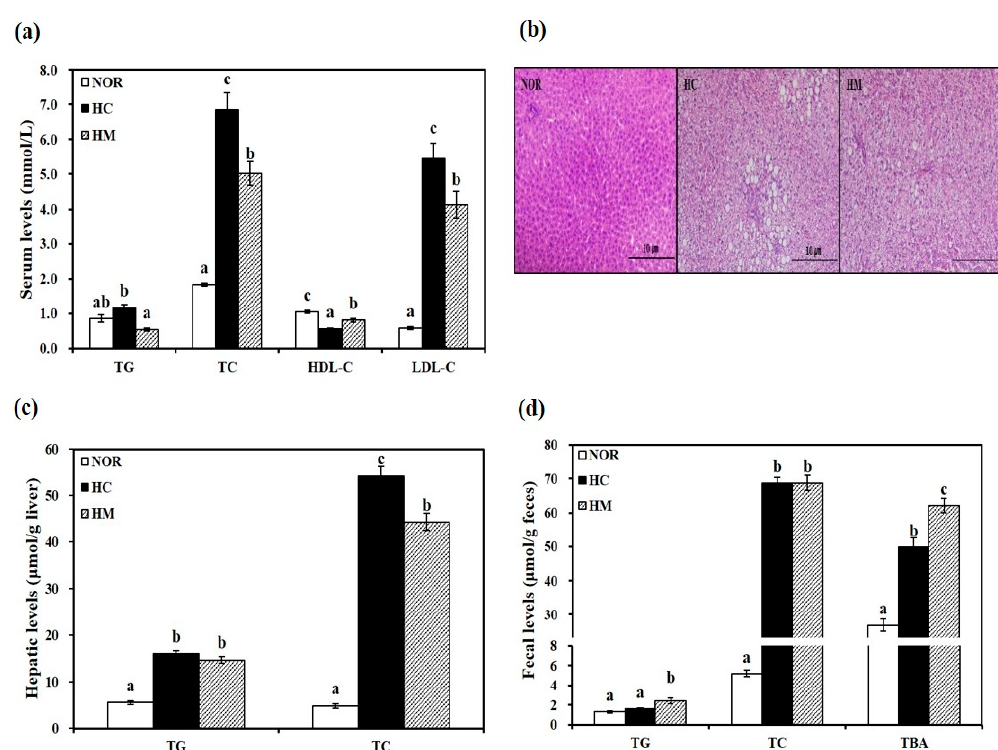
Figure 1. Influence of high hydrostatic pressure mulberry fruit extract on serum ( a ), hepatic ( c ), and fecal lipid profiles ( d ). ( b ) Representative hematoxylin and eosin (H&E) stained liver tissue (scale bars = 100 µ m; magnification of 200 × ). Data are expressed as mean ± SEM ( n = 6). Bars with di ff erent letters (a, b, c) are statistically di ff erent at p < 0.05. HDL-C, HDL-cholesterol; LDL-C, LDL-cholesterol; TBA, total bile acid; TC, total cholesterol; TG, triglyceride; NOR, normal diet; HC, high-cholesterol / cholic acid diet containing 1% cholesterol and 0.5% cholic acid; and HM, HC + 0.4% high hydrostatic pressure mulberry fruit extract.